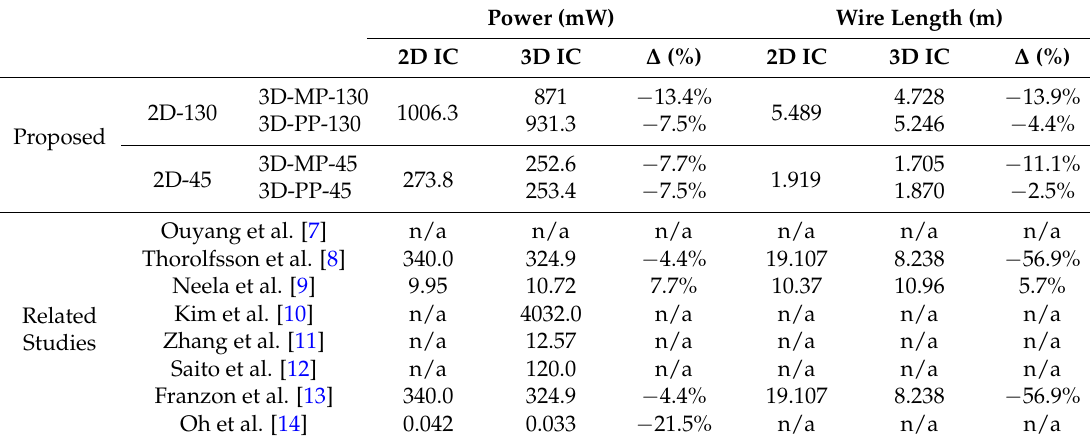
Table 10. Comparisons of the power and wire length reductions in this study with those in related